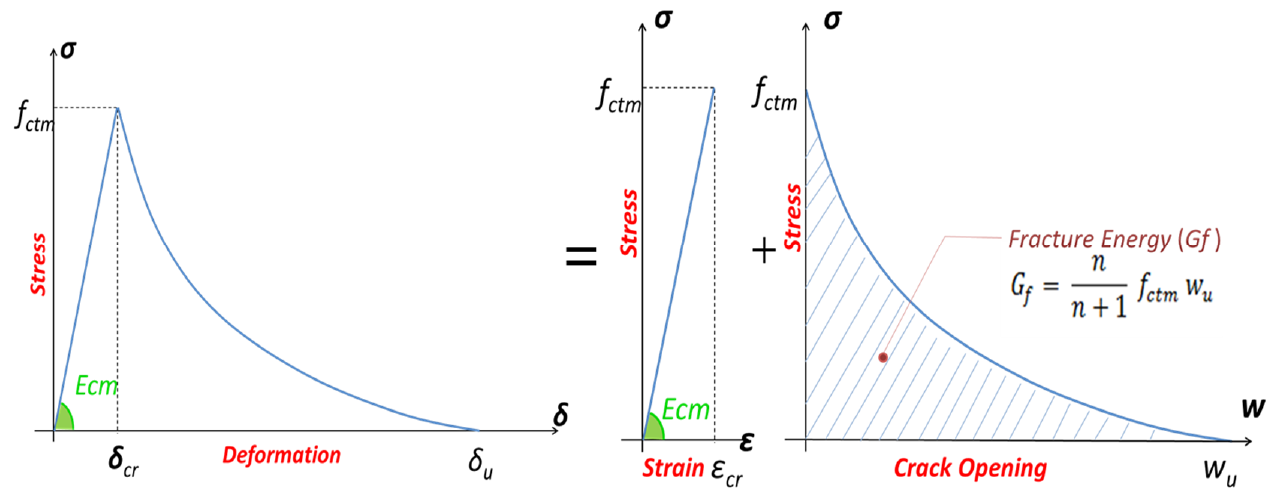
Figure 2. The adopted behavior of concrete in tension [6,7].